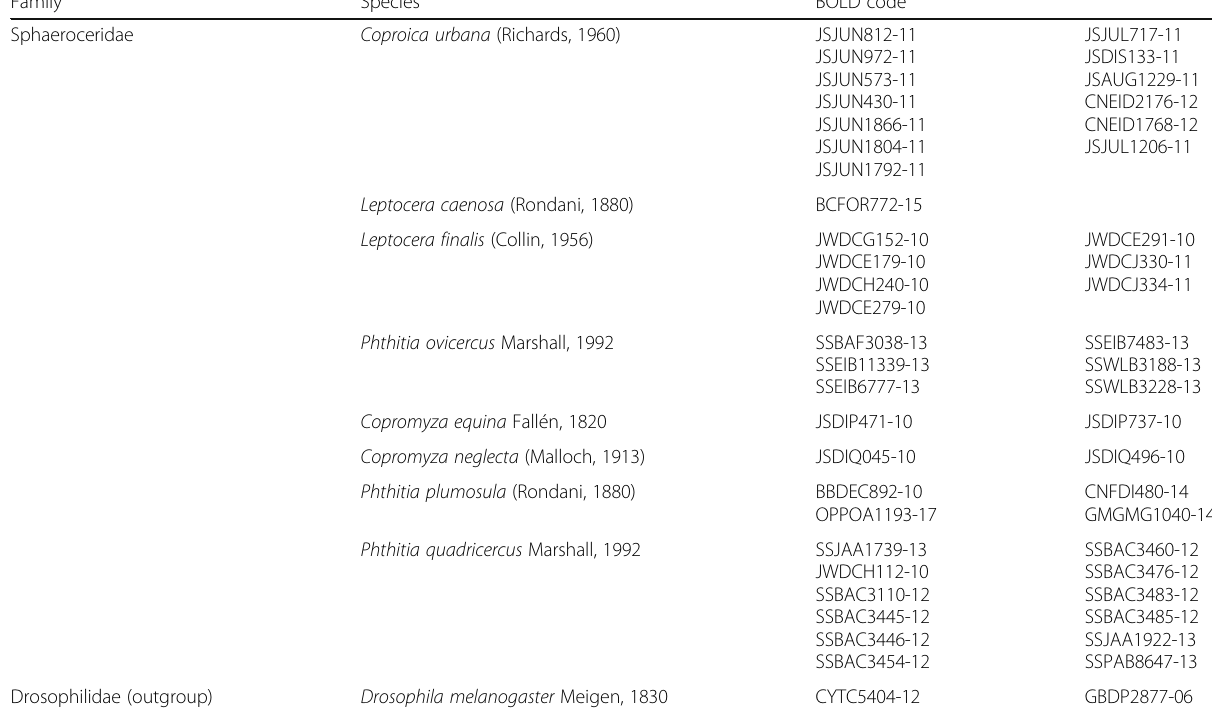
Table 2 COI sequences of Sphaeroceridae downloaded from BOLD and included in the analysis Family Species BOLD code Sphaeroceridae